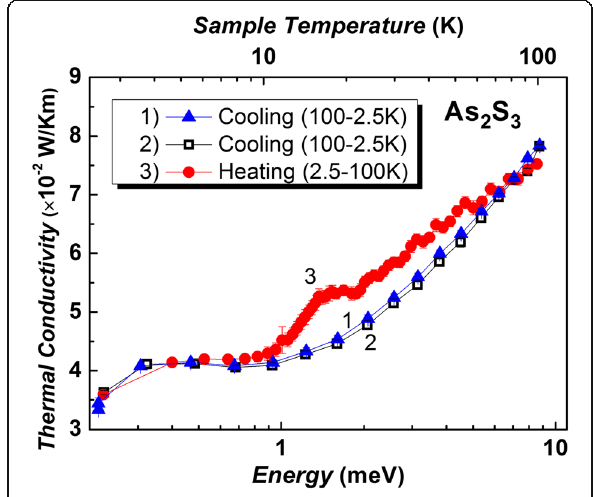
Fig. 4 Low-temperature thermal conductivity of g-As 2 S 3 during cooling ( curve 1 and 2 ) and heating ( curve 3 ) cycles. ( Color online )